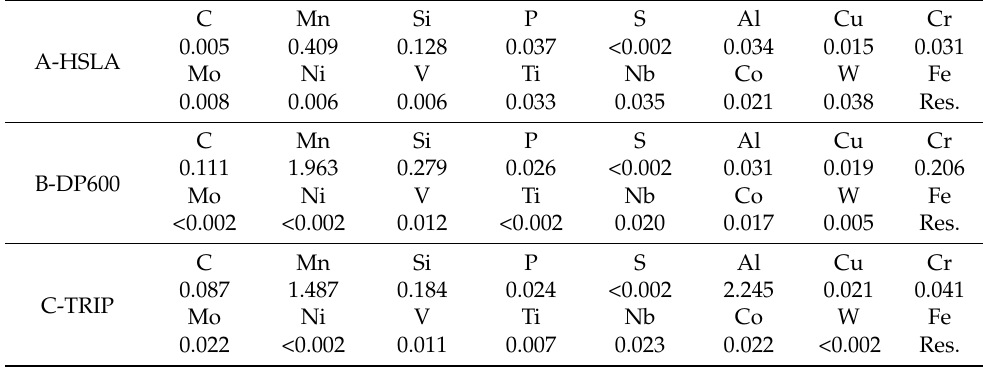
Table 1. Chemical composition of welded steel sheets (wt %). Table 2. Mechanical properties of the evaluated sheets specified by the manufacturer.